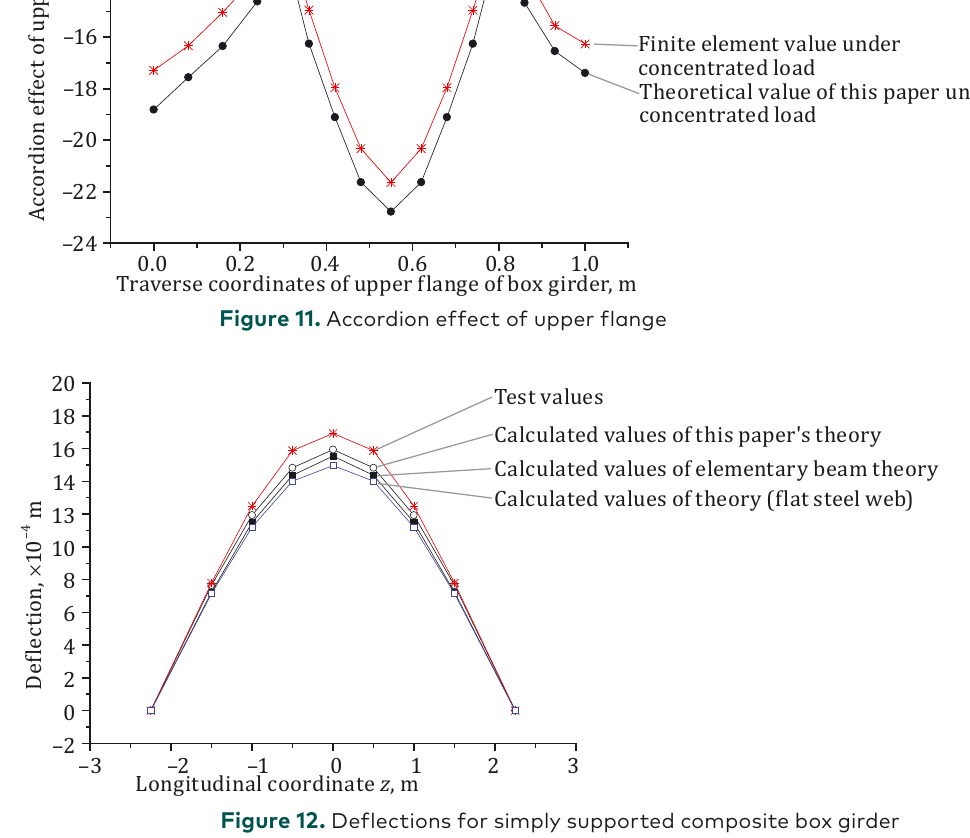
Finite element values under uniformly distributed load loadTheoretical value of this paper under uniformly distributed